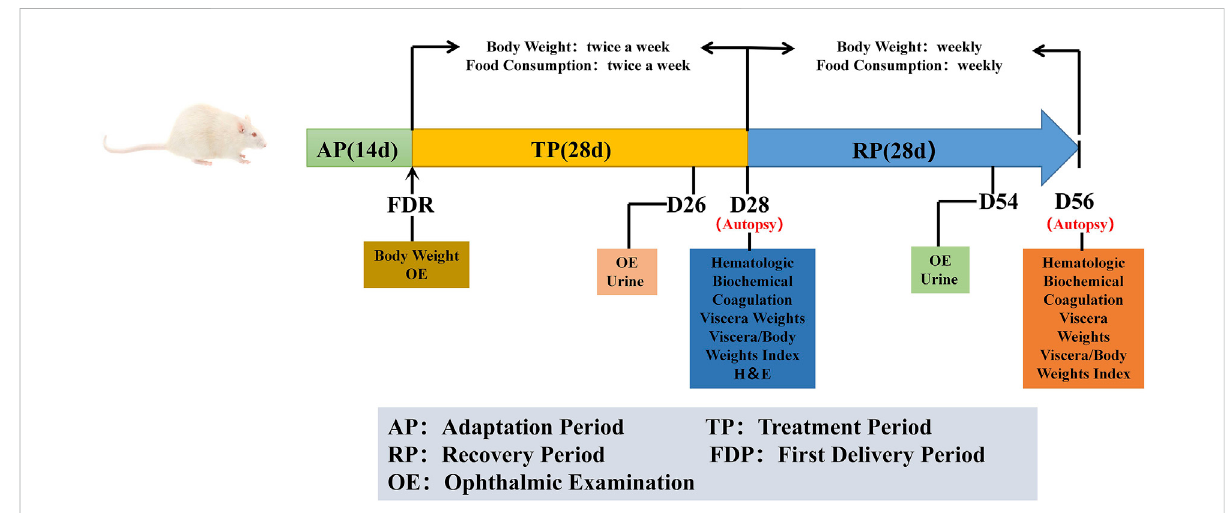
FIGURE 1 Representative experimental scheme. ‘ AP ’ indicates 14 days of suitability rearing before the experiment; ‘ FDR ’ was de fi ned as trial day 1 (D1), body weight and ophthalmic examinations were performed. The whole experiment lasted for 56 days, it was divided into treatment period (TP) and recoveryperiod(RP).Duringthetrial,cageobservationdaily;detailedclinicalsignsobservation,bodyweightandfoodconsumptionwereperformed weekly. Ophthalmic examination and urine examination are performed before the end of the treatment and the recovery periods (D26 and D54). Hematologic, biochemical and coagulation examinations were tested at the end of the treatment period and the recovery period (D28 and D56), and necropsy, organ weight and histopathological examination were performed after the animals were